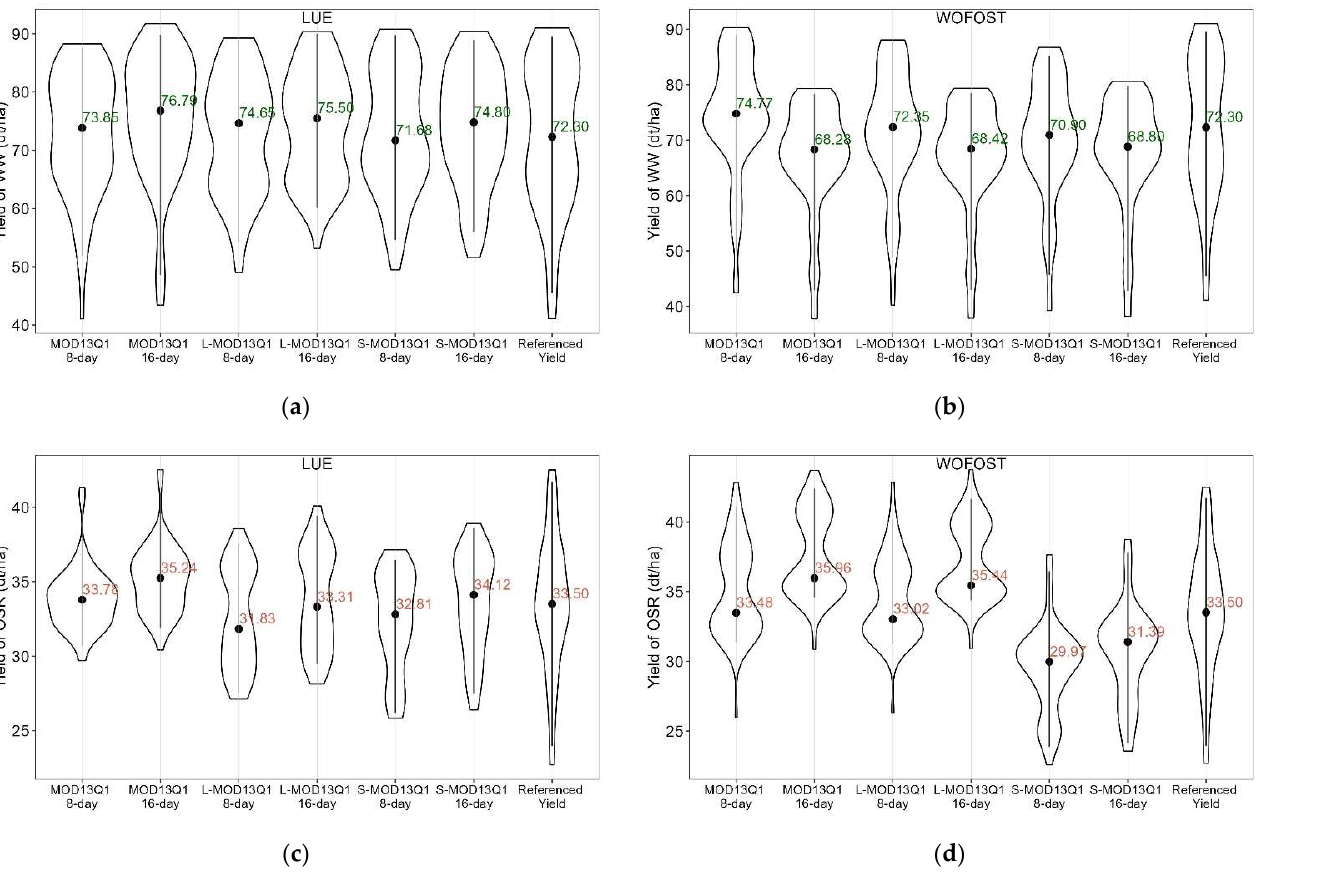
Figure 8. The violin plots compare the crop yields of referenced (at 95% confidence interval) and modelled yields obtained from multi-source data (MOD13Q1, L-MOD13Q1, and S-MOD13Q1) at 8 and 16 days of temporal scales of ( a , b ) WW and ( b , d ) OSR using the ( a , c ) LUE and ( b , d ) WOFOST models in 2019. The green-coloured text represents WW and the orange-coloured text represents OSR. The text values represent the median yield values of every product.